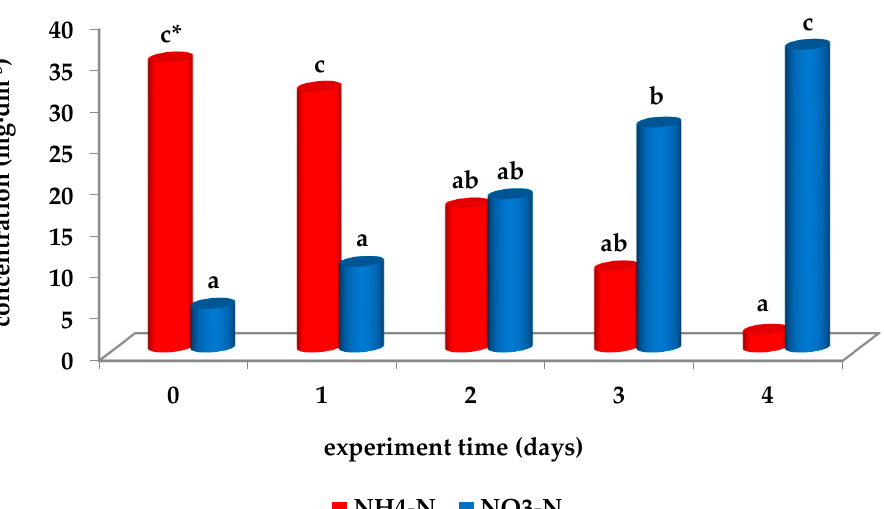
Figure 6. Settlement of activated sludge by nitrifying bacteria; * averages marked with the same letters are not significantly different by Tukey test ( α = 0.05) (one-way ANOVA, separately for concentration of NH 4 -N and NO 3 -N). Table 7. The differences in average concentration of NH 4 -N and NO 3 -N (mg · dm − 3 ) in the Municipal and Industrial Sewage Treatment Plant in O´swi˛ecim.